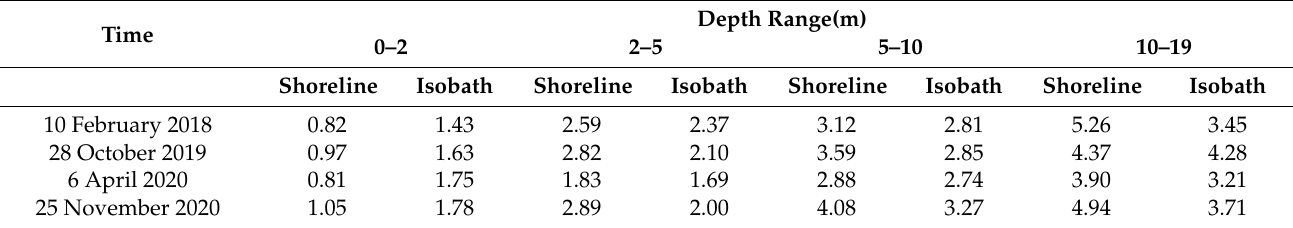
Table 11. Comparison of RMSEs between two methods. Units: